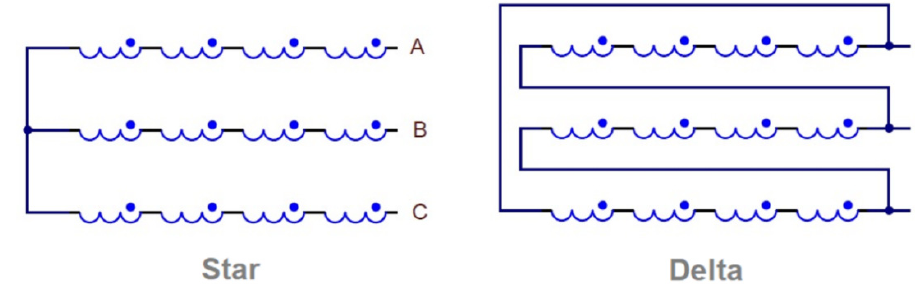
Figure 3. Possible connection schemes for four poles. Figure 2. Diagram connection pole phase. Figure 2. Diagram connection pole phase.